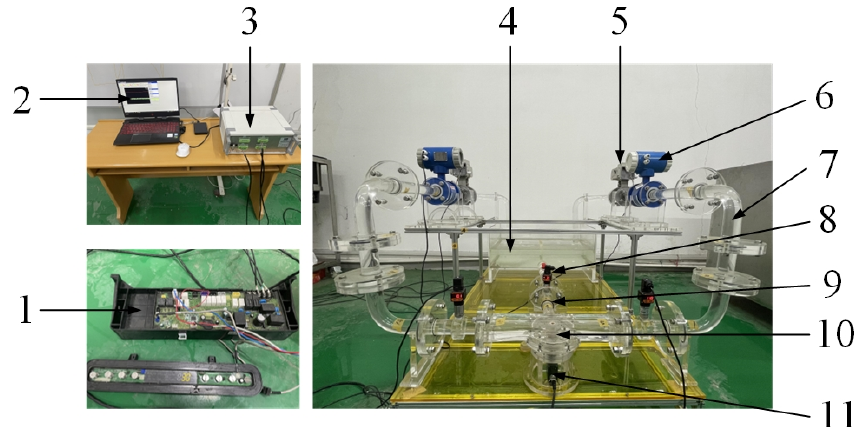
Figure 6. Hydraulic performance test bench for the new type of dishwasher pump. 1: motor speed controller, 2: computer, 3: data-acquisition system, 4: water tank, 5: electromagnetic valve, 6: turbine flowmeter, 7: outflow pipe, 8: pressure gauge, 9: inlet pipe, 10: dishwasher pump, and 11: torsiograph.